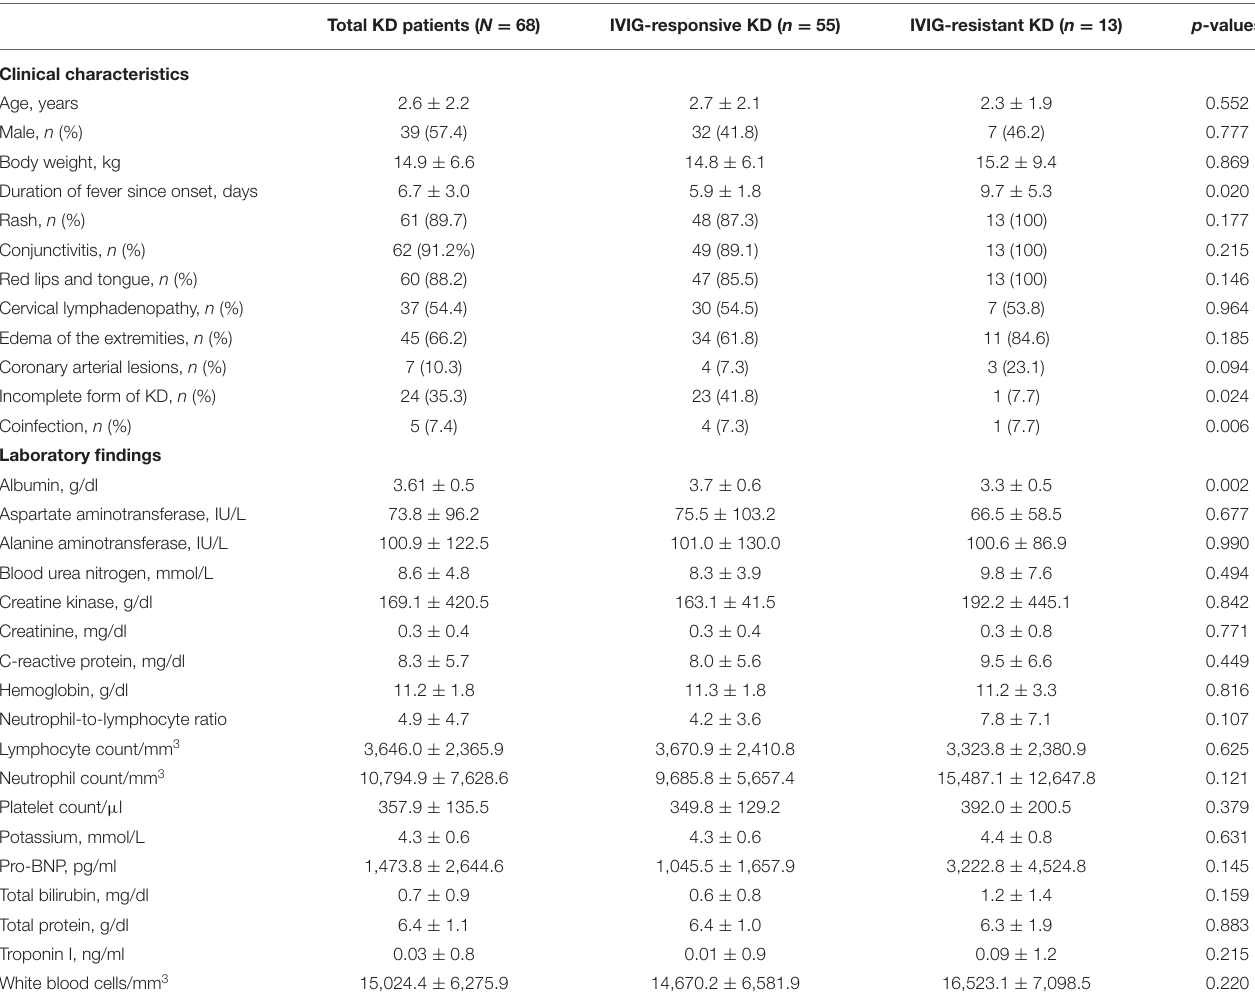
TABLE 1 | Clinical characteristics and laboratory findings of Kawasaki disease (KD) patients at the time of